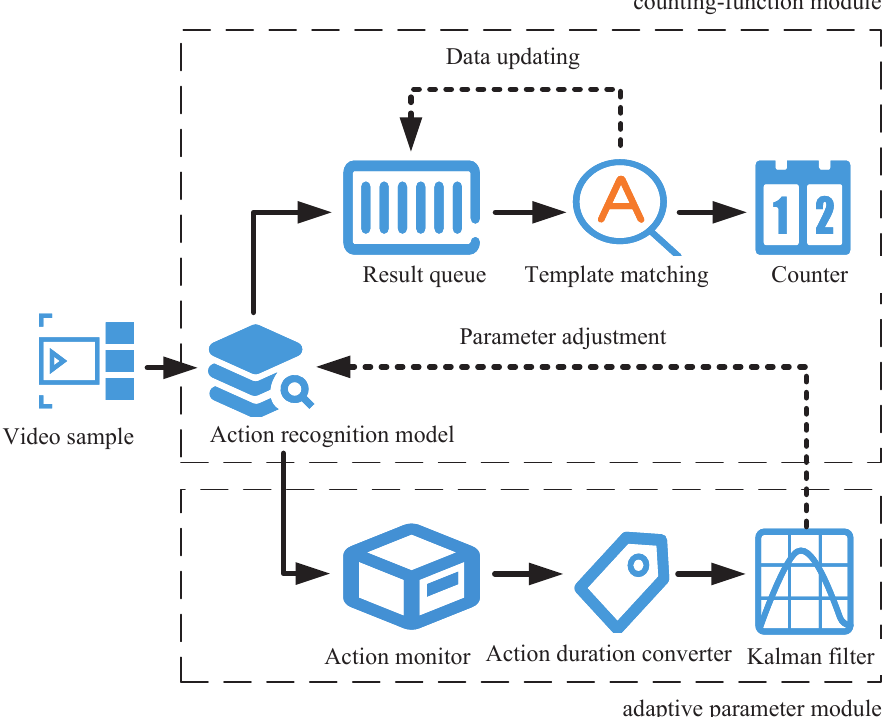
Figure 1. System